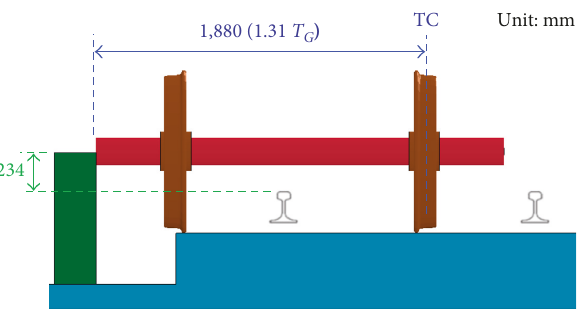
Figure 10: Overview of distance effect